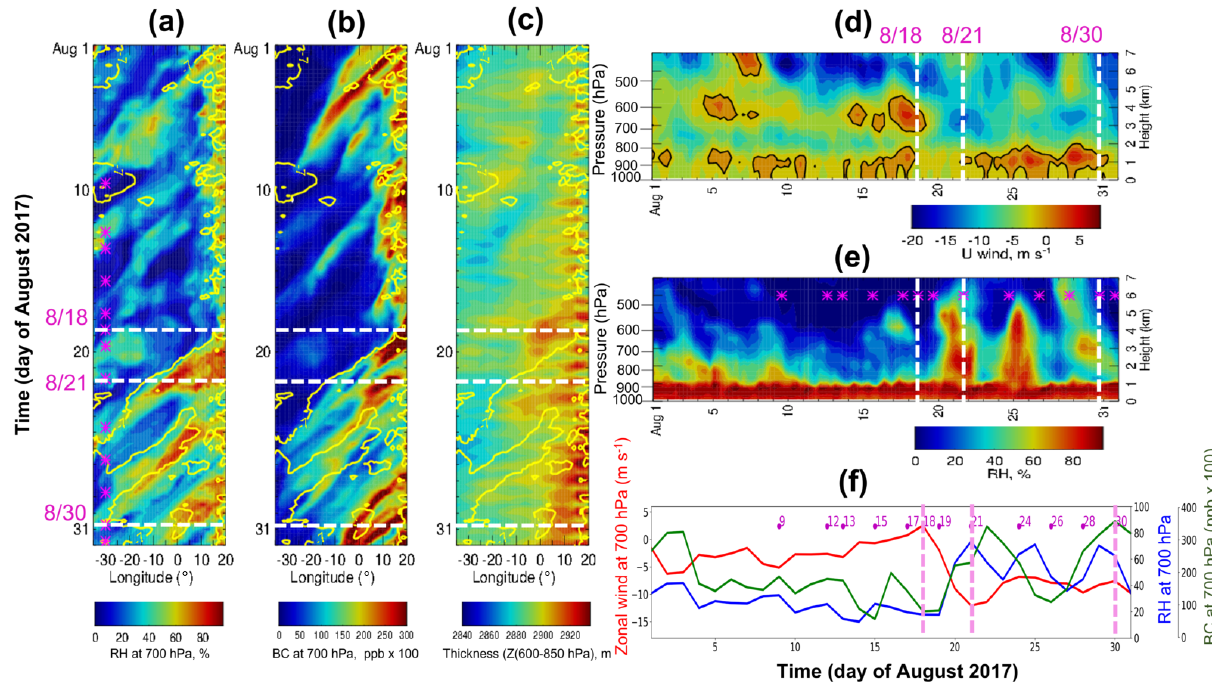
Figure 7. Longitude–time cross section of every 6h (a) 700hPa RH (%), (b) 700hPa BC aerosol (shading; ppb × 100), and (c) thickness (geopotential height difference at 600–850hPa; high values ( > 2920m) over a southern African plateau represents the heat low; m) averaged over 5–7 ◦ S during August 2017. Panels (a) – (c) are overlaid by 700hPa zonal wind isotach (yellow line; − 7ms − 1 ). (d–e) Altitude–time cross section of zonal wind and RH at 6 ◦ S, averaged over 0–10 ◦ E during August 2017. The black contour in panel (d) represents the zero value of zonal wind. (f) Daily time series of the 700hPa zonal wind (red line; ms − 1 ), 700hPa RH (blue line; %), and 700hPa BC (green line; ppb × 100) averaged over 5–7 ◦ S and 0–10 ◦ E. The dashed white lines indicate the flight days investigated further in this study, and the magenta asterisks (and numbers in panel f ) represent the flight days during the August 2017